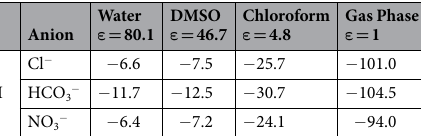
Table 1. Calculated binding energies (Kcal/mol) for compound 1a .H + and different anions. Data were calculated in media of different relative permittivities.